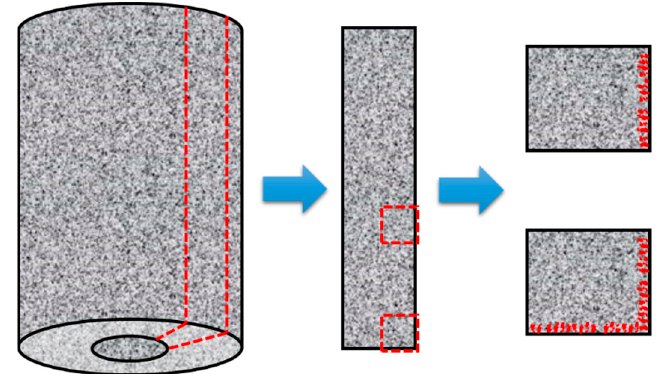
Figure 6. Schematic diagram of sample cutting before and after